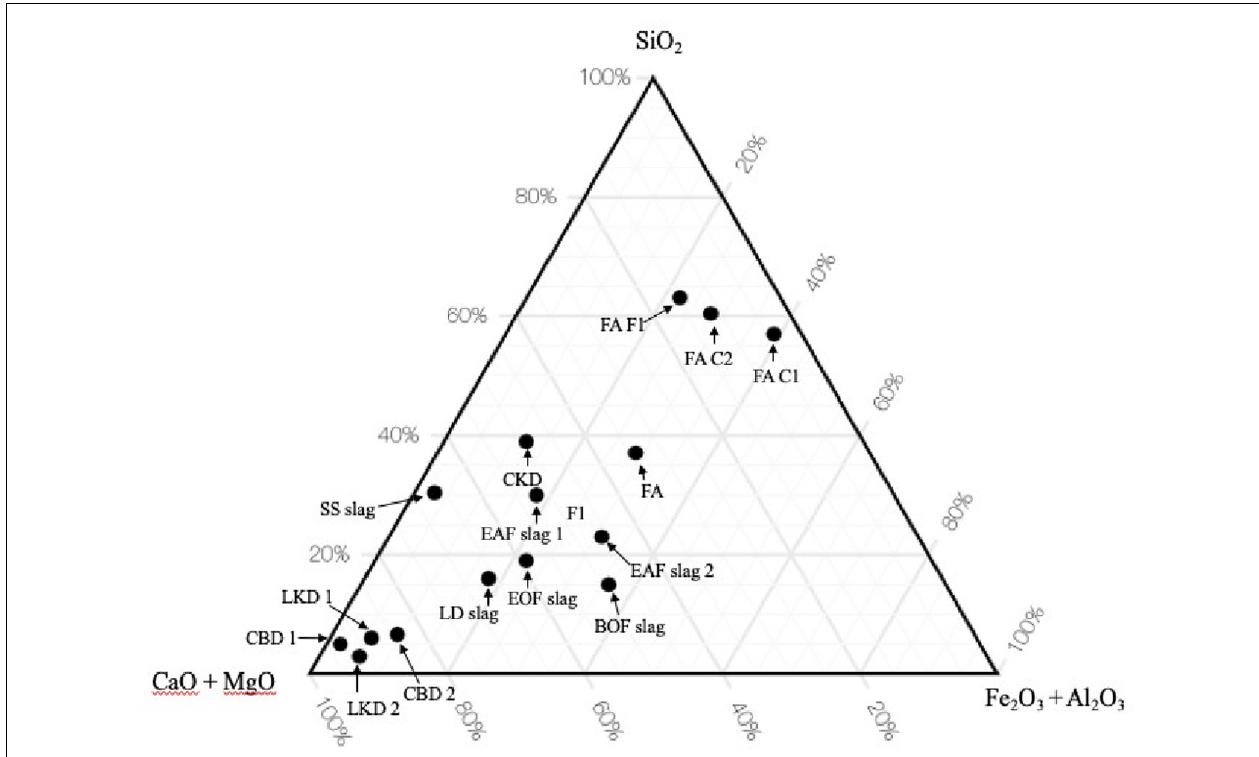
FIGURE 3 | Normalized phase diagram showing the variability in chemistry of industrial process wastes (Chad et al., 2015; Fathy et al., 2016; Sabapathy et al., 2017; Carbon8 Systems Ltd, 2020).